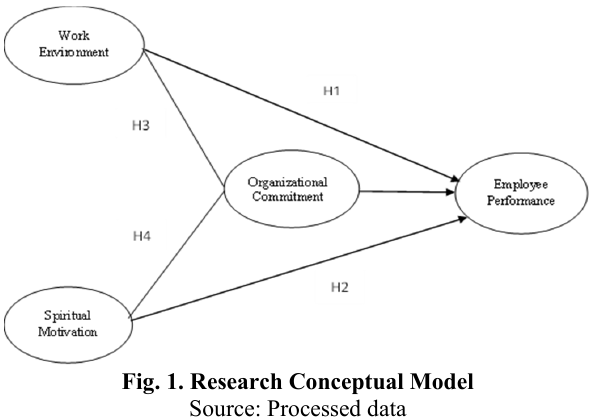
Fig. 1. Research Conceptual Model Source: Processed